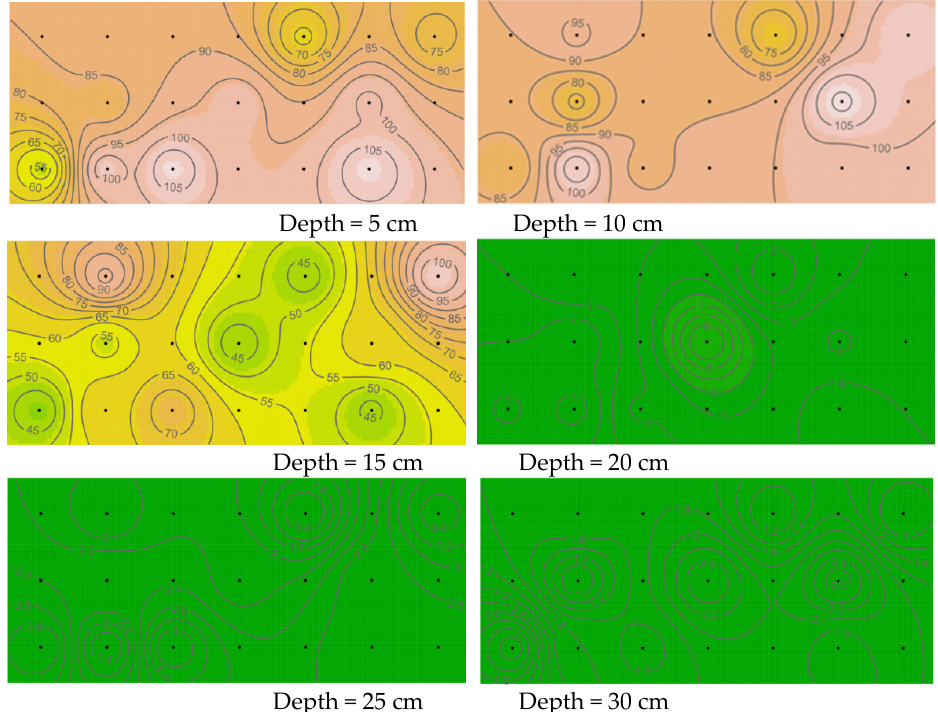
Figure 9. Spatial distribution of microorganisms in the different layers of the sandy soil (unit: 10 5 cfu/mL).